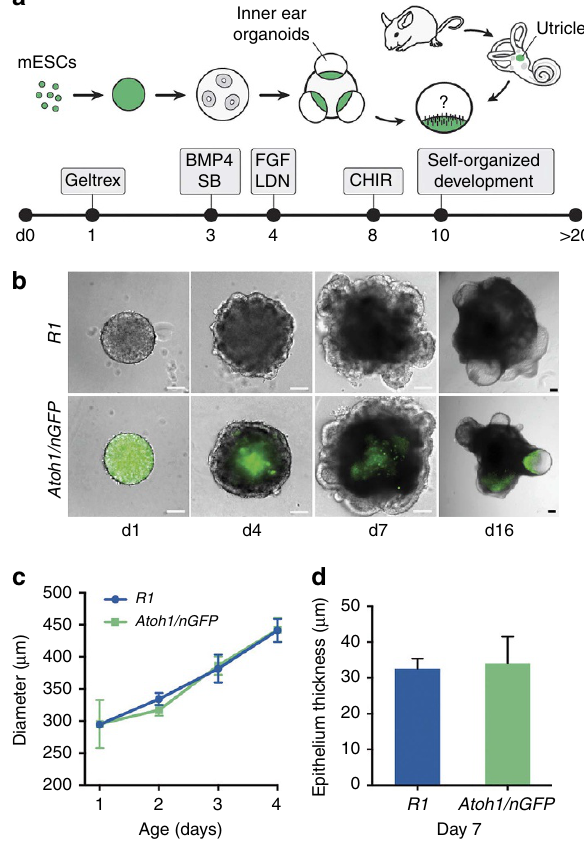
Figure 1 | Generation of inner ear organoids from R1 and Atoh1/nGFP ES cells. ( a ) Schematic overview of the inner ear induction protocol. ( b ) Comparison of aggregate morphology during otic induction in R1 and Atoh1/nGFP cells. Scale bars, 100 m m. Inner ear organoids can be seen protruding from the aggregates in the day 16 panels. ( c ) The mean ( ± s.e.m.) diameter of R1 and Atoh1/nGFP cell aggregates increases at a similar rate over time. ( d ) The mean ( ± s.e.m.) apparent thickness of outer epithelia on day 7 aggregates is not significantly different between R1 and Atoh1/nGFP